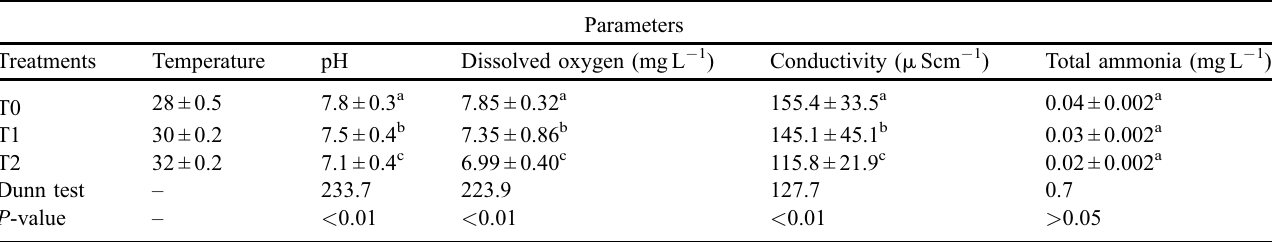
Table 1. Water quality parameters in tanks of Macrobrachium amazonicum juveniles during 90-day of cultivation at different temperature treatments.